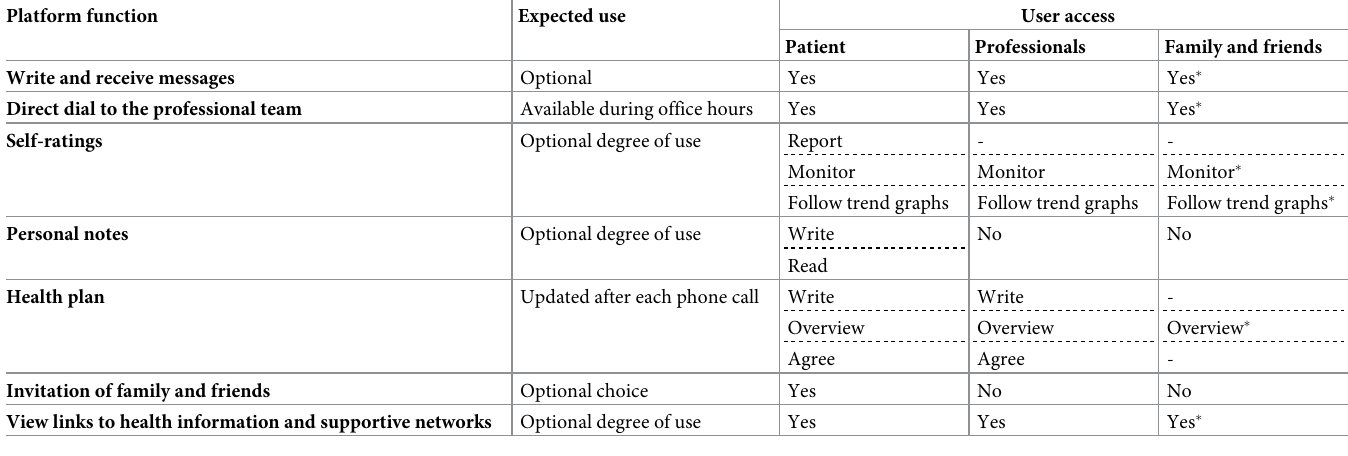
Table 1. An overview of the content in the PROTECT intervention, expected use and access to digital platform functions in the three user groups. Platform